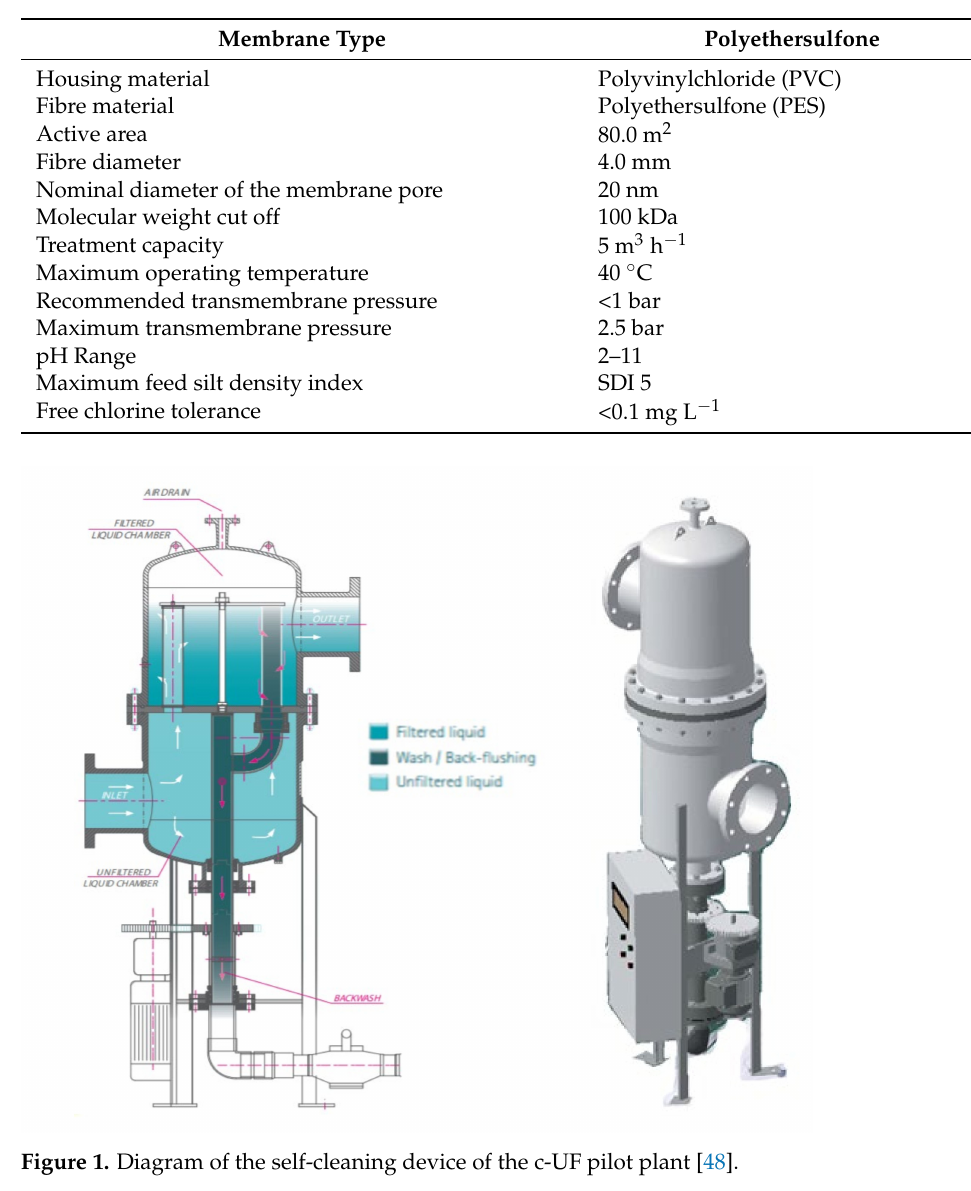
Table 2. Characteristics of the ultrafiltration (UF) membranes.